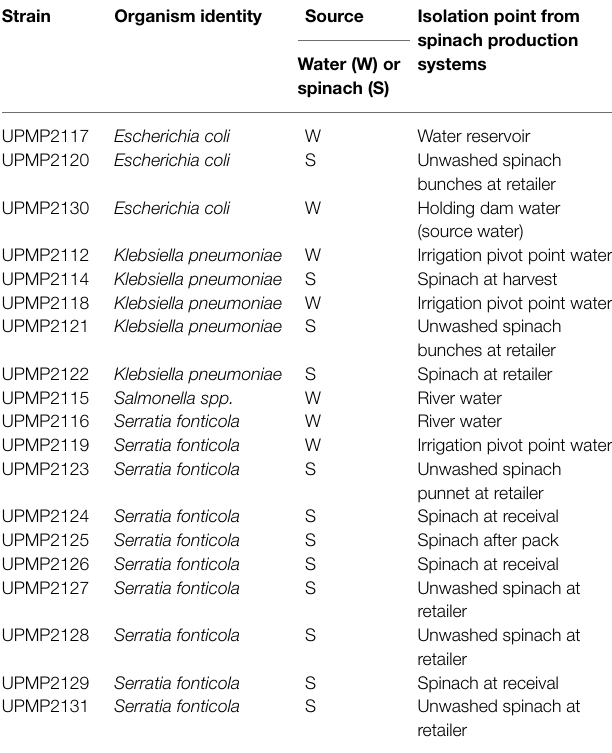
TABLE 1 | Isolates selected for whole genome sequence analysis from the agricultural environment in spinach supply chains, Gauteng Province, South